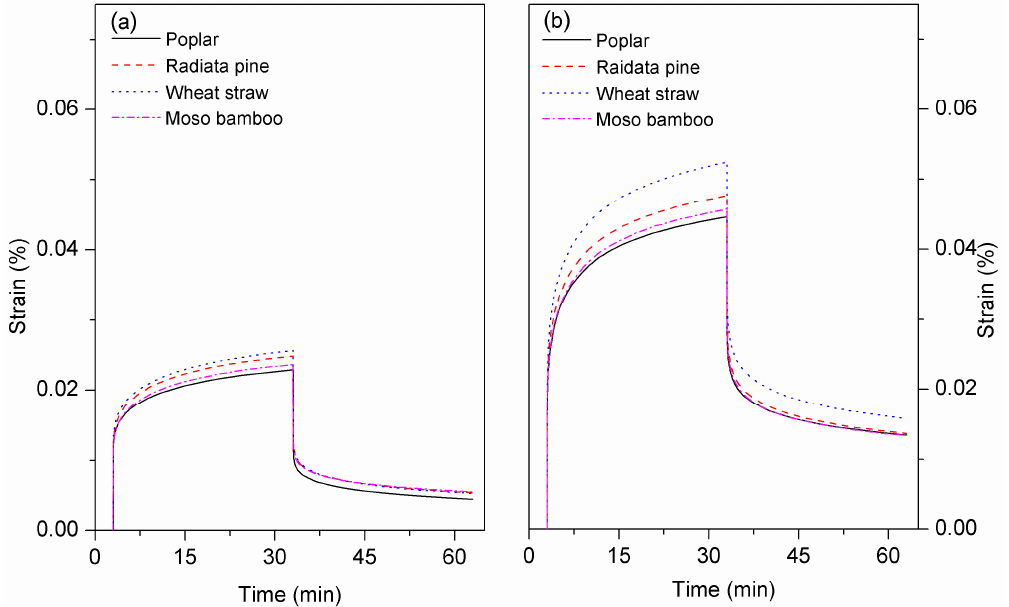
Figure 7. Creep-recovery curves of the composites at ( a ) 30 °C and ( b ) 60 °C.